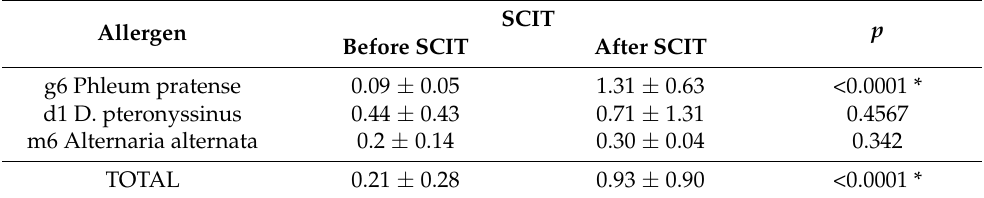
Table 2. Changes of sIgG4 levels after SCIT, mean (kUA/L) and standard deviation (SD). SCIT Allergen